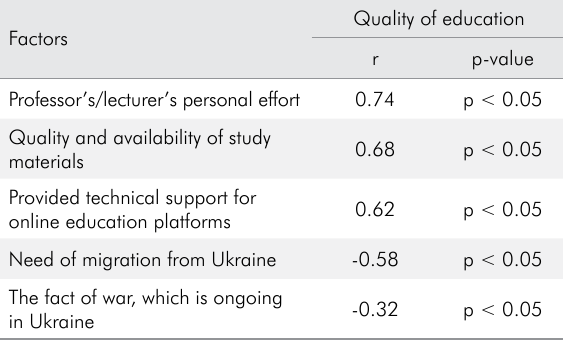
Table 2. Correlations between studied parameters and satisfaction with the quality of education.